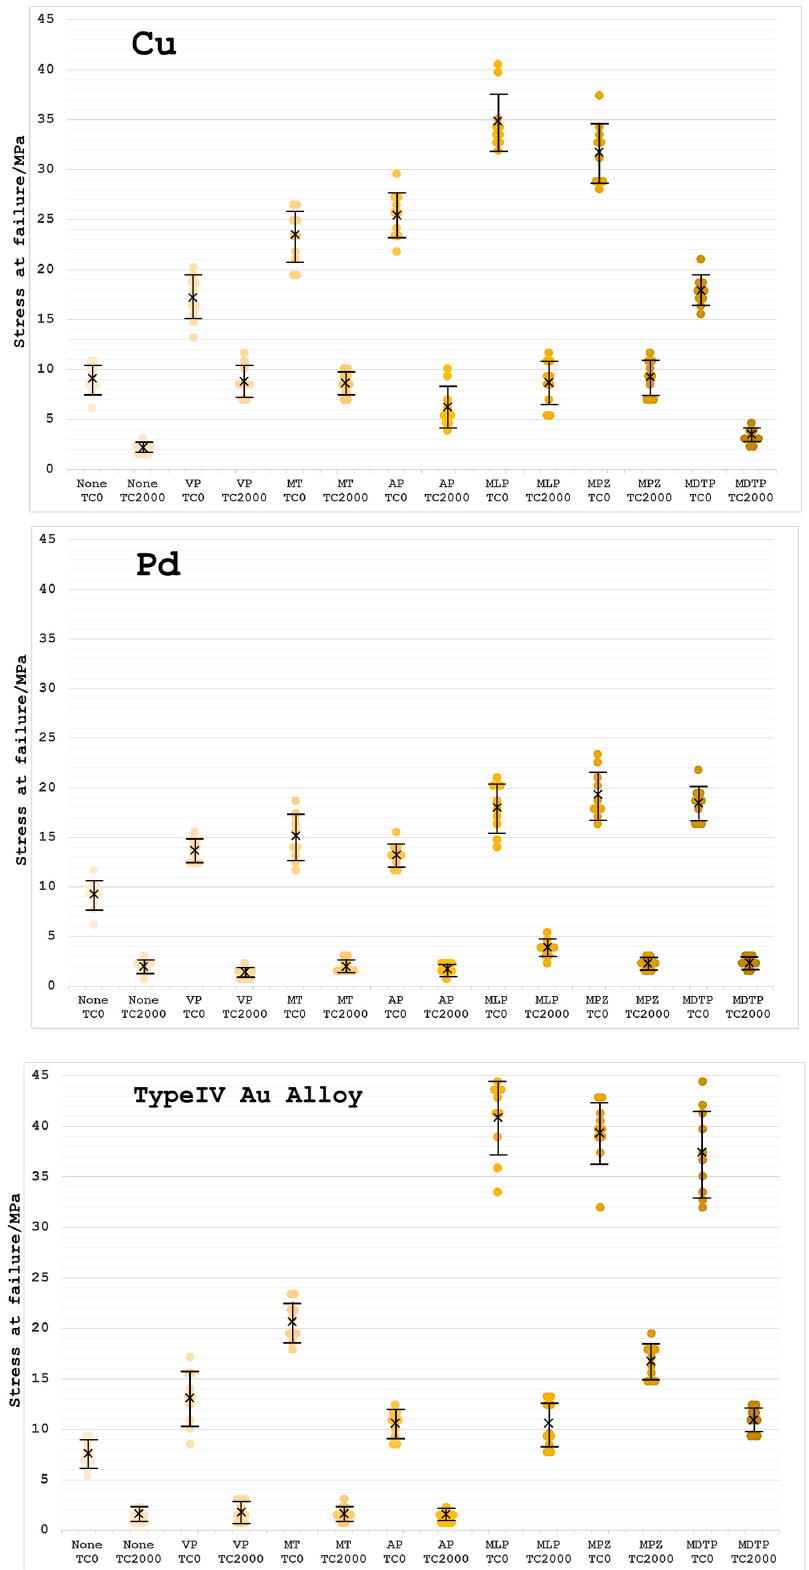
Figure 3. Every raw data point of each shear bond strength present in the scatter diagrams for each metal. The marked × represents the mean value and the error bar standard deviation.